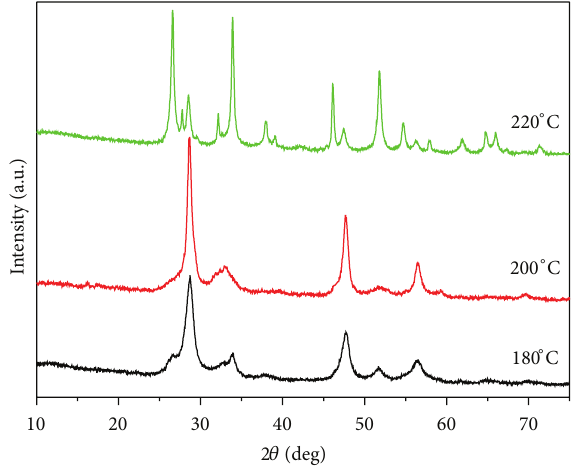
Figure 4: XRD spectra of the obtained samples for 7.5h at the different temperatures.